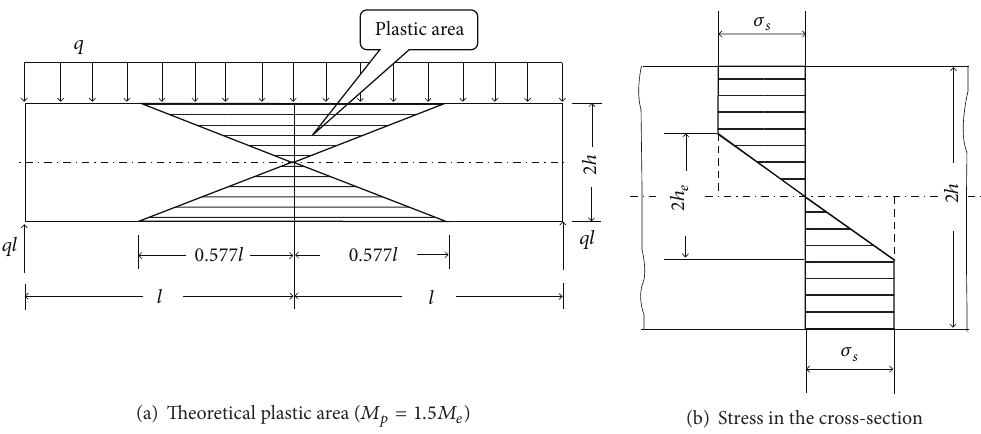
Figure 3: Theoretical plastic area of flexural beam under static load.